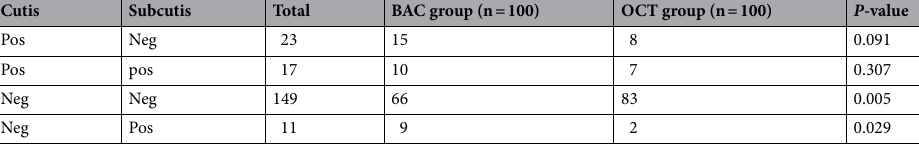
Table 3. Comparison of the possible bacteria detection combinations in cutis and subcutis between the alcohol-based antiseptic with additional benzalkonium chloride (BAC group) and the antiseptic with additional octenidine dihydrocloride (OCT group). Pos = positive bacteria detection; Neg = negative bacteria detection.